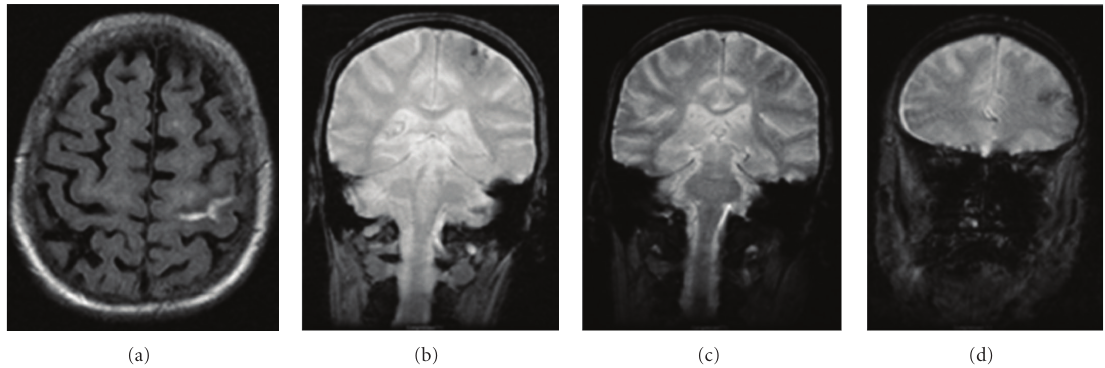
Figure 2: MR images of the brain. Axial FLAIR image (image a) of the index case confirms the finding of left central sulcus hemorrhage seen on the CT scan. Coronal gradient echo images (image b) demonstrate corresponding loss of signal within the left central sulcus. Coronal gradient echo images (images c, d) demonstrate signal loss within other adjacent cortical and subcortical areas consistent with hemorrhages and siderosis. Imaging findings and clinical presentation support the working diagnosis of cerebral amyloid angiopathy.